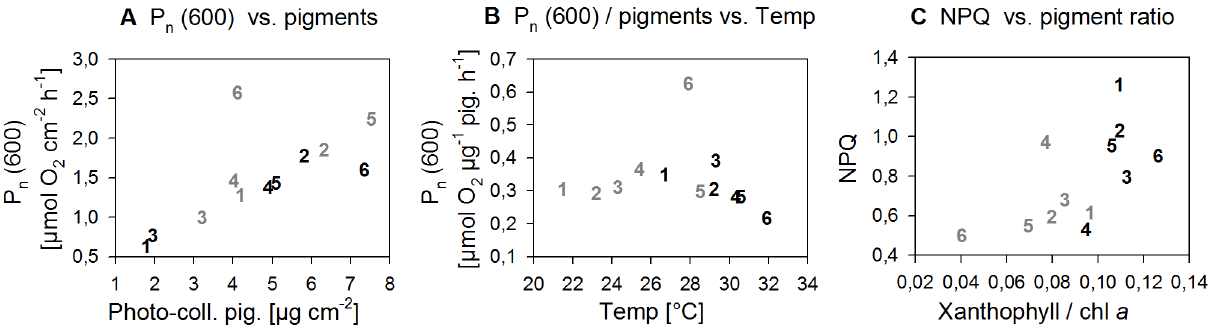
Figure 4. Zooxanthellae performance plotted against A) + C) zooxanthellae composition and B) temperature at all sites (1–6) in Sep11 (black) and Mar12 (grey). Data points represent means (standard errors are listed in table S1 and S2).